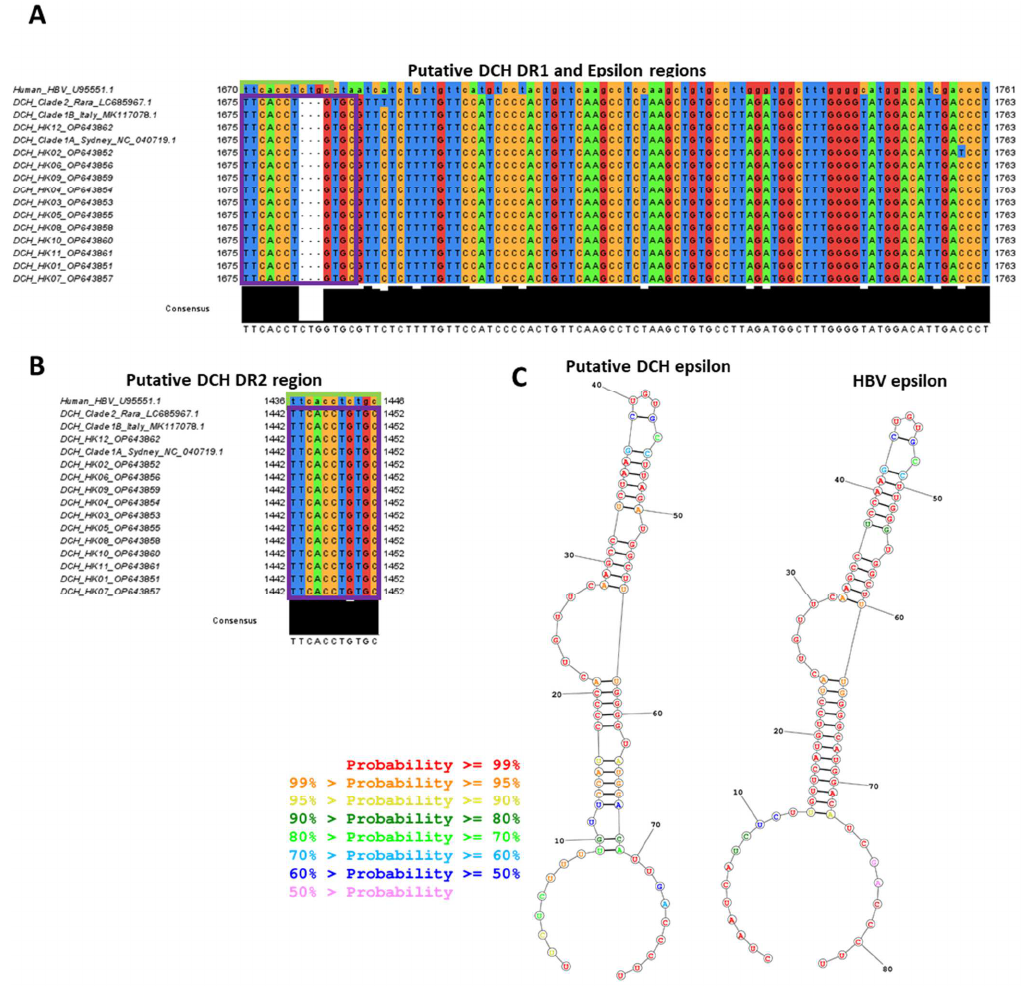
Figure 2. Sequence alignment and analysis of DCH isolates compared to human HBV sequences. The whole genomes of the HK DCH isolates were aligned to human HBV DNA sequence (GenBank